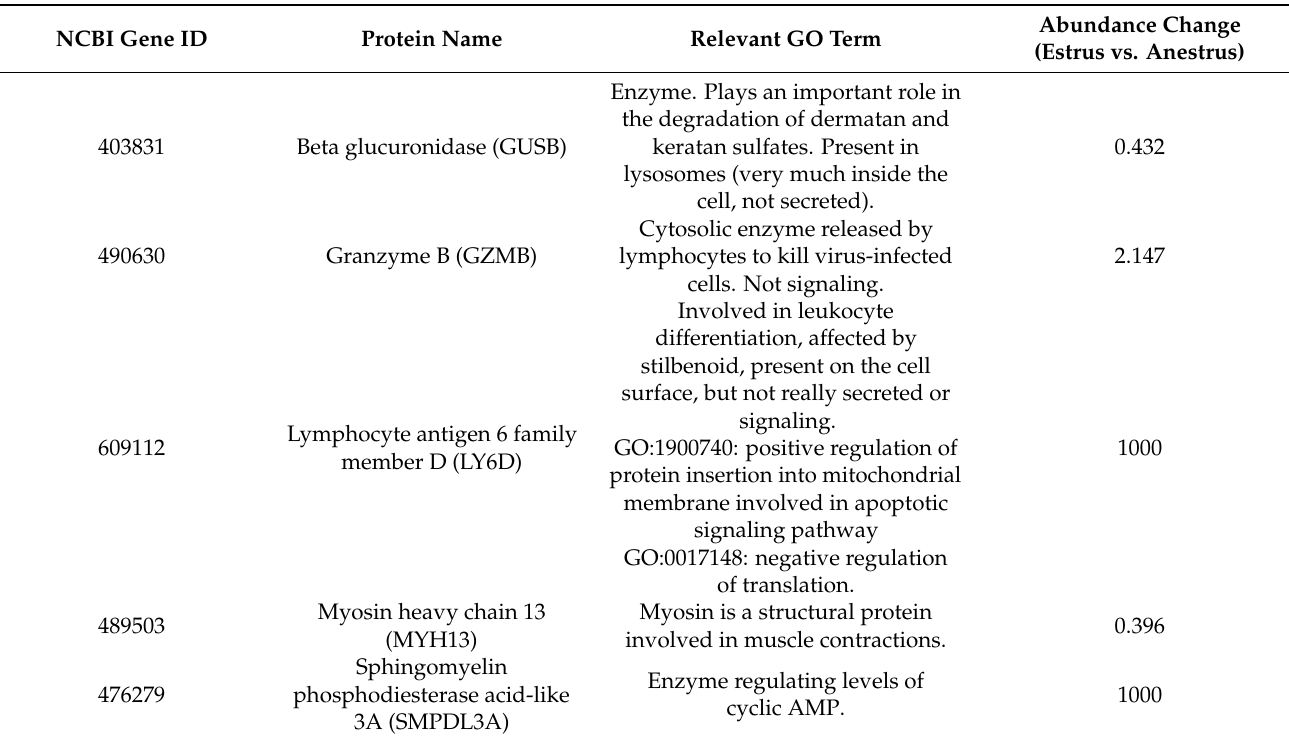
Table 5. List of other proteins significantly altered in estrus vs. anestrus